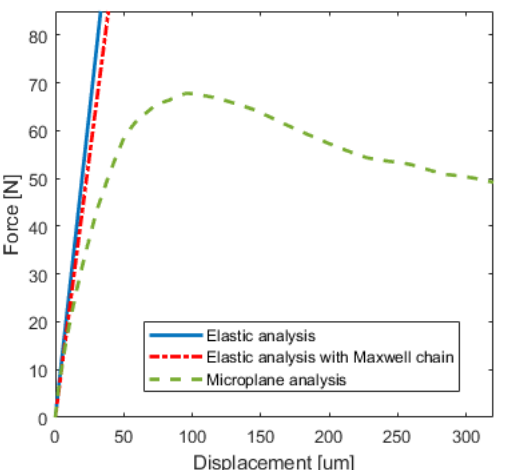
Figure 3. Results from finite element analysis: Cube with an edge 1 cm, loading pure